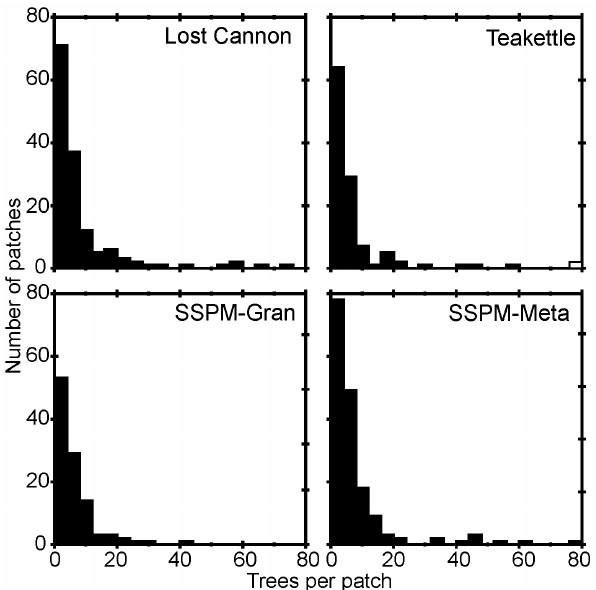
Figure 8. Tree patch distributions in four old-growth Jeffrey pine-mixed conifer forests. At Teakettle, the open bar represents the three largest patches comprising 181 to 211 trees.